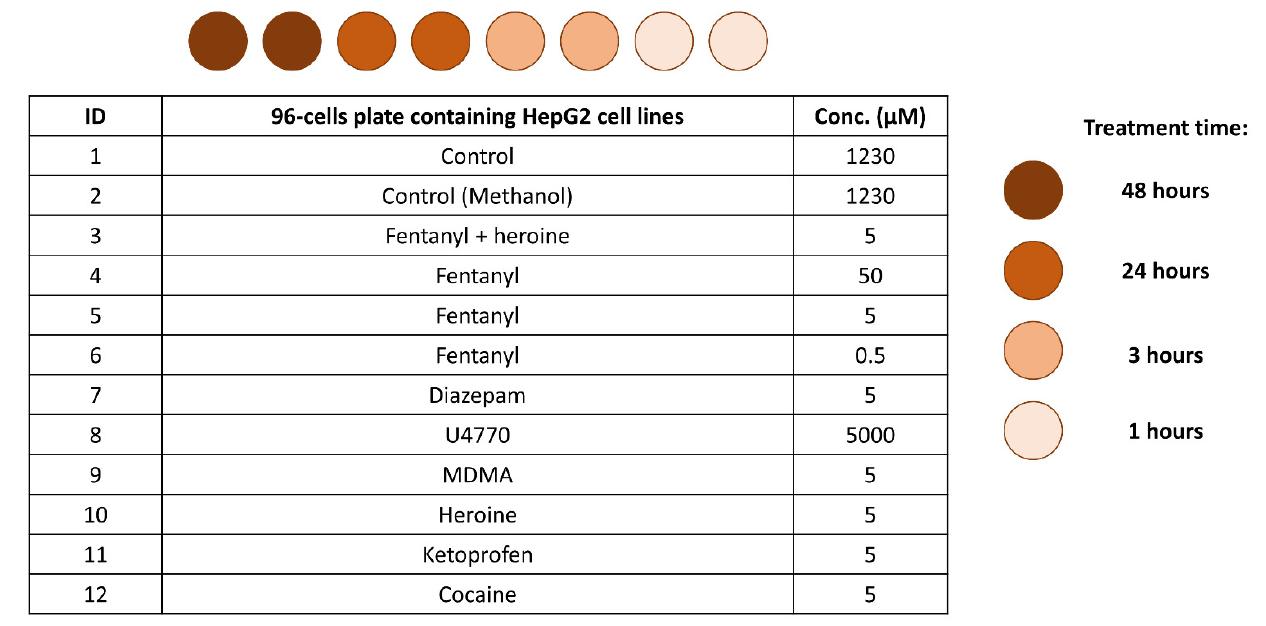
Figure 1. Scheme of the in vitro samples preparation involving 10 psychoactive substance or combination of substances (whose concentration levels are reported in µ M), and 4 experimental times for all the psychoactive substances. Samples were prepared in duplicate.